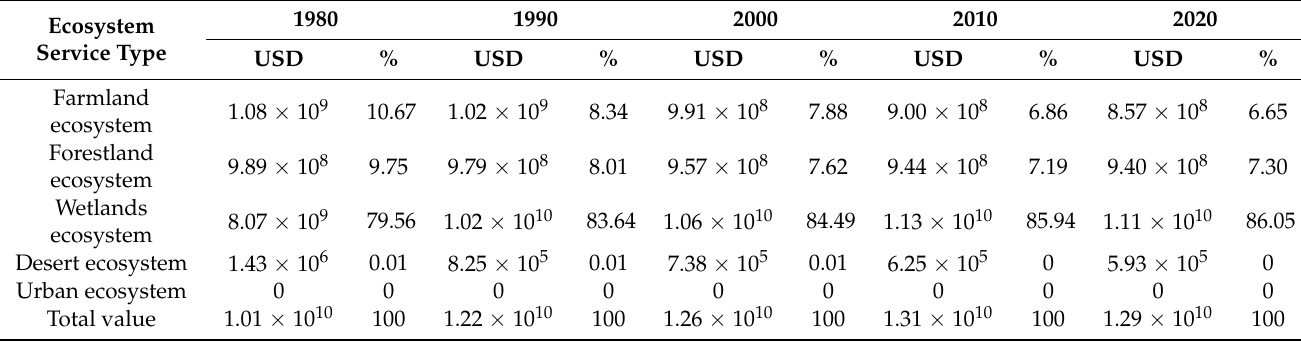
Table 6. Ecosystem service total value of the study area in 1980, 1990, 2000, 2010, and 2020.